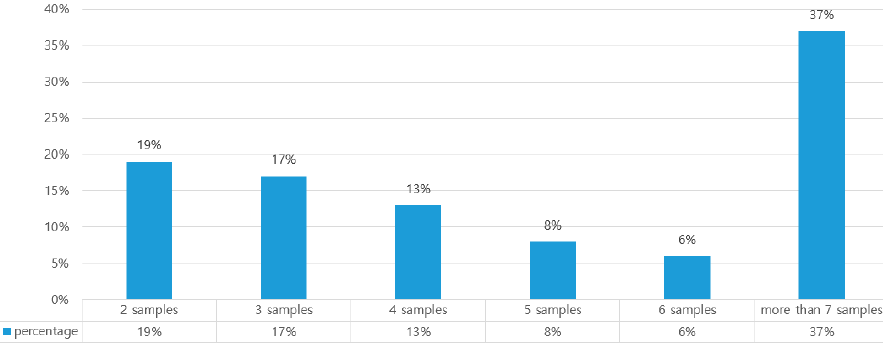
Figure 6. Distribution of FAQ categories according to the number of queries.